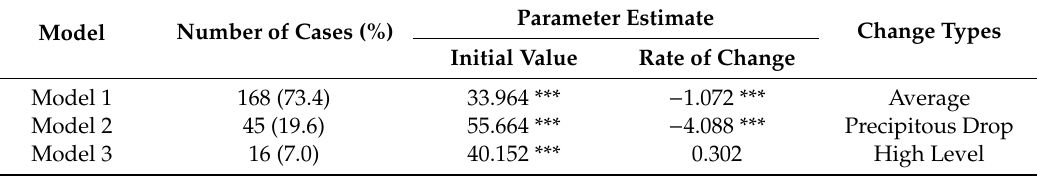
Table 4. Estimates of the Initial Value and the Rate of Change by Suicide Rate Change